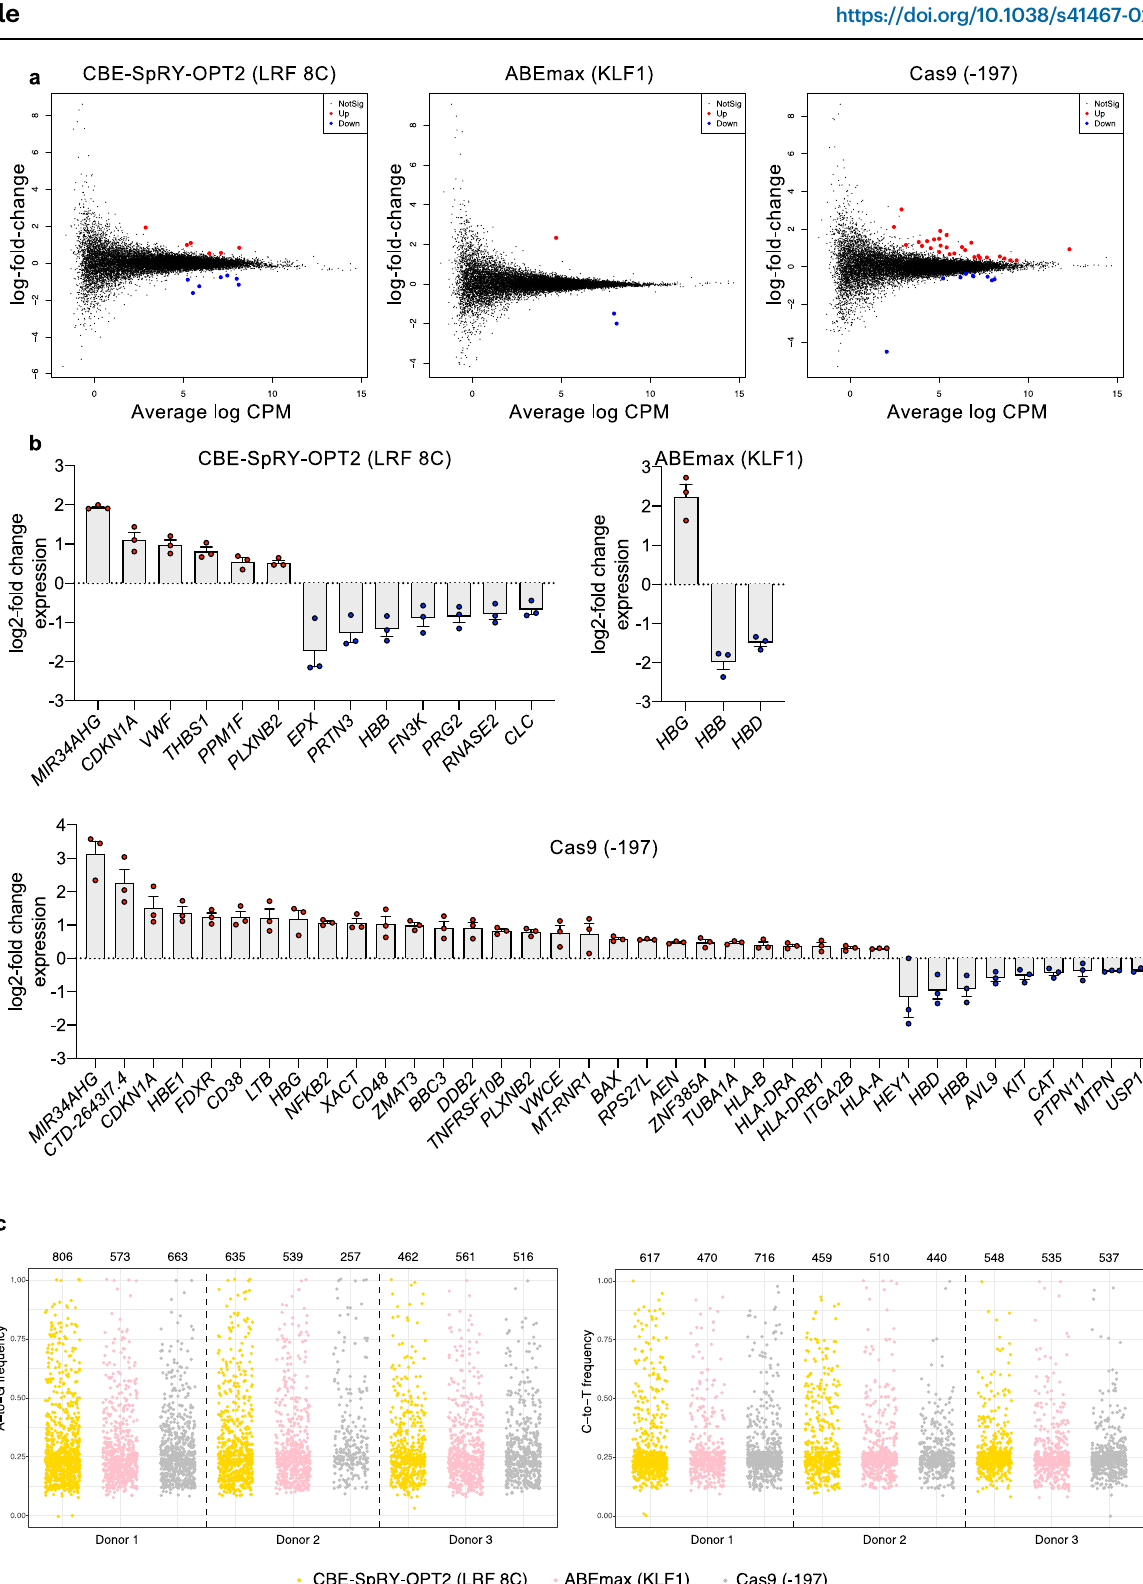
Nature Communications| (2022)